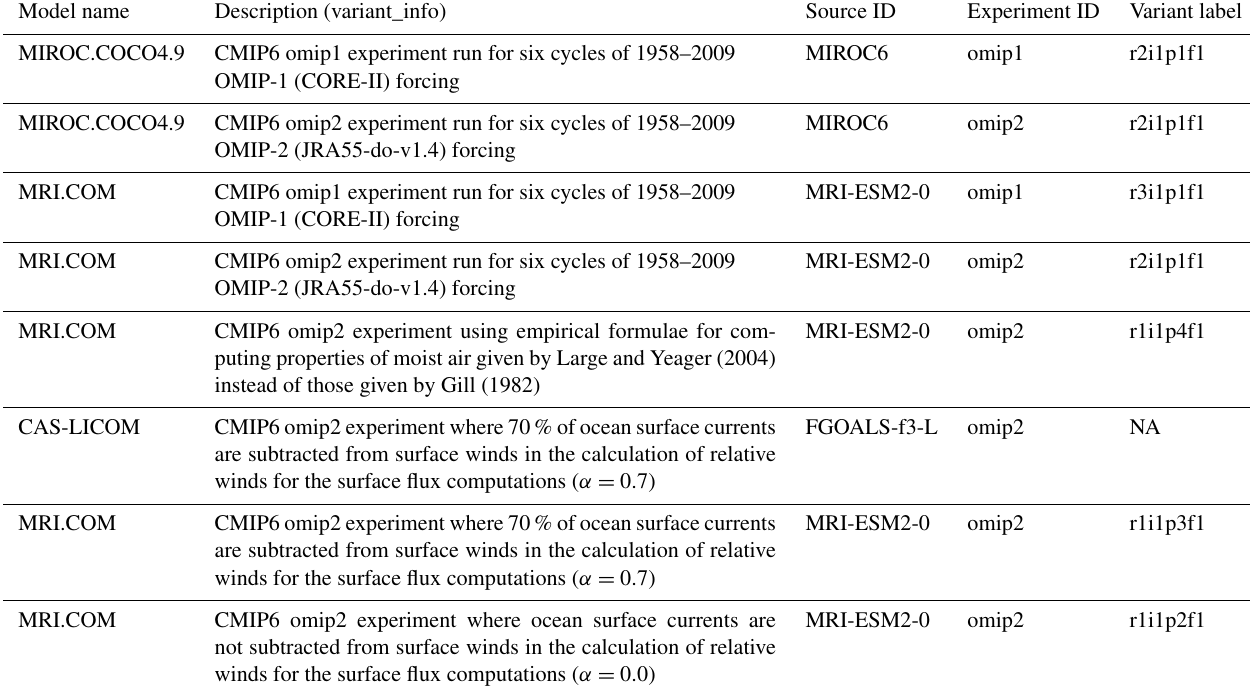
Table B1. Description of the additional experiments conducted for Appendix B with the minimum information to identify the experiments (if available) in